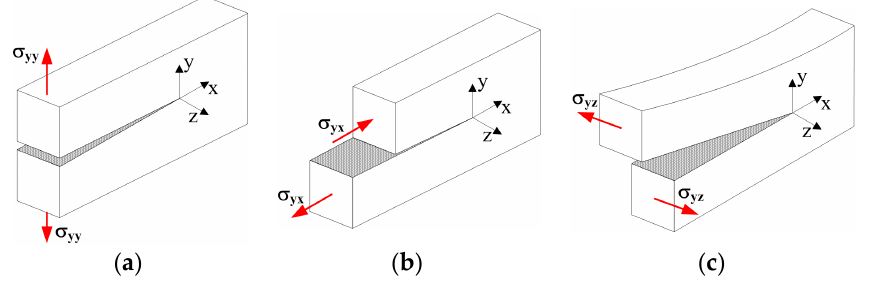
Figure 1. Different fracture modes: ( a ) mode I; ( b ) mode II; ( c ) mode III. σ yy , σ yx , σ yz —stresses causing growth of initial crack.